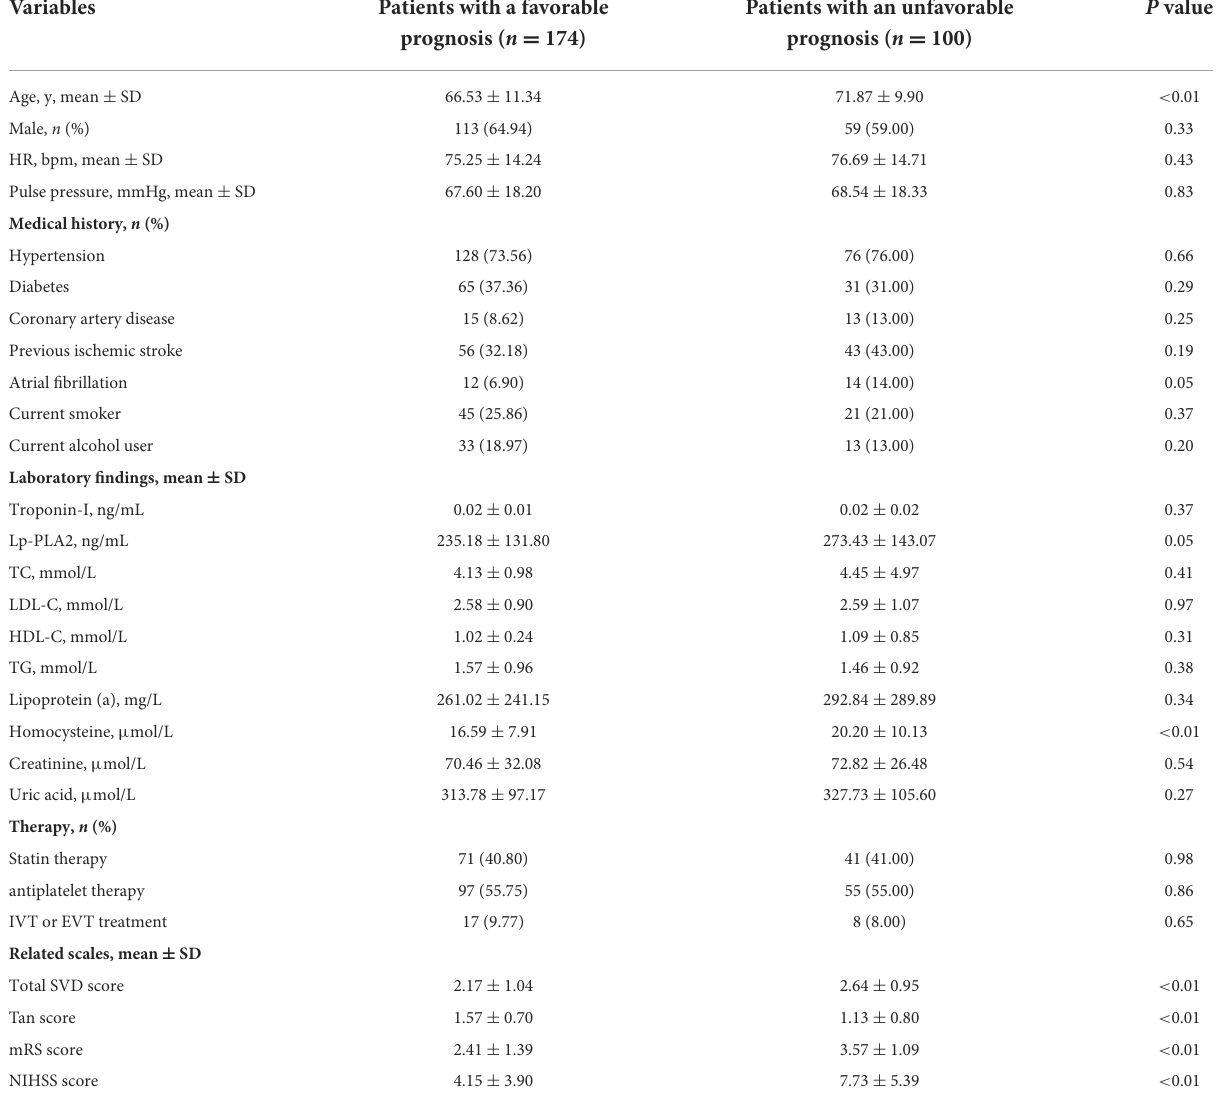
TABLE 1 Clinical characteristics of patients with and without a favorable prognosis at baseline ( n = 274). Variables Patients with a favorable Patients with an prognosis ( n = 174)